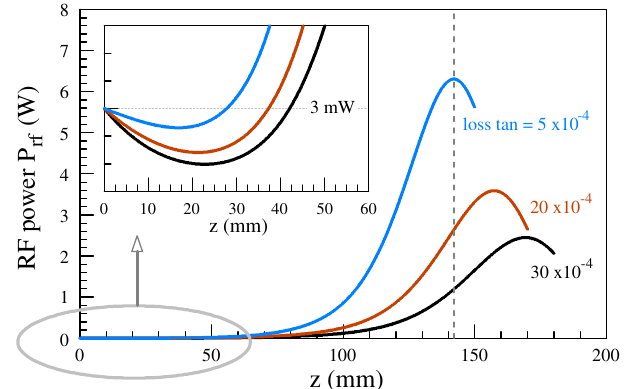
FIG. 13. (Color) The rf power profiles for different dielectric losses. The rf powers at z (cid:3) 142 mm are, respectively, 6.3 W, 2.6 W, and 1.2 W for three different loss tangent values.